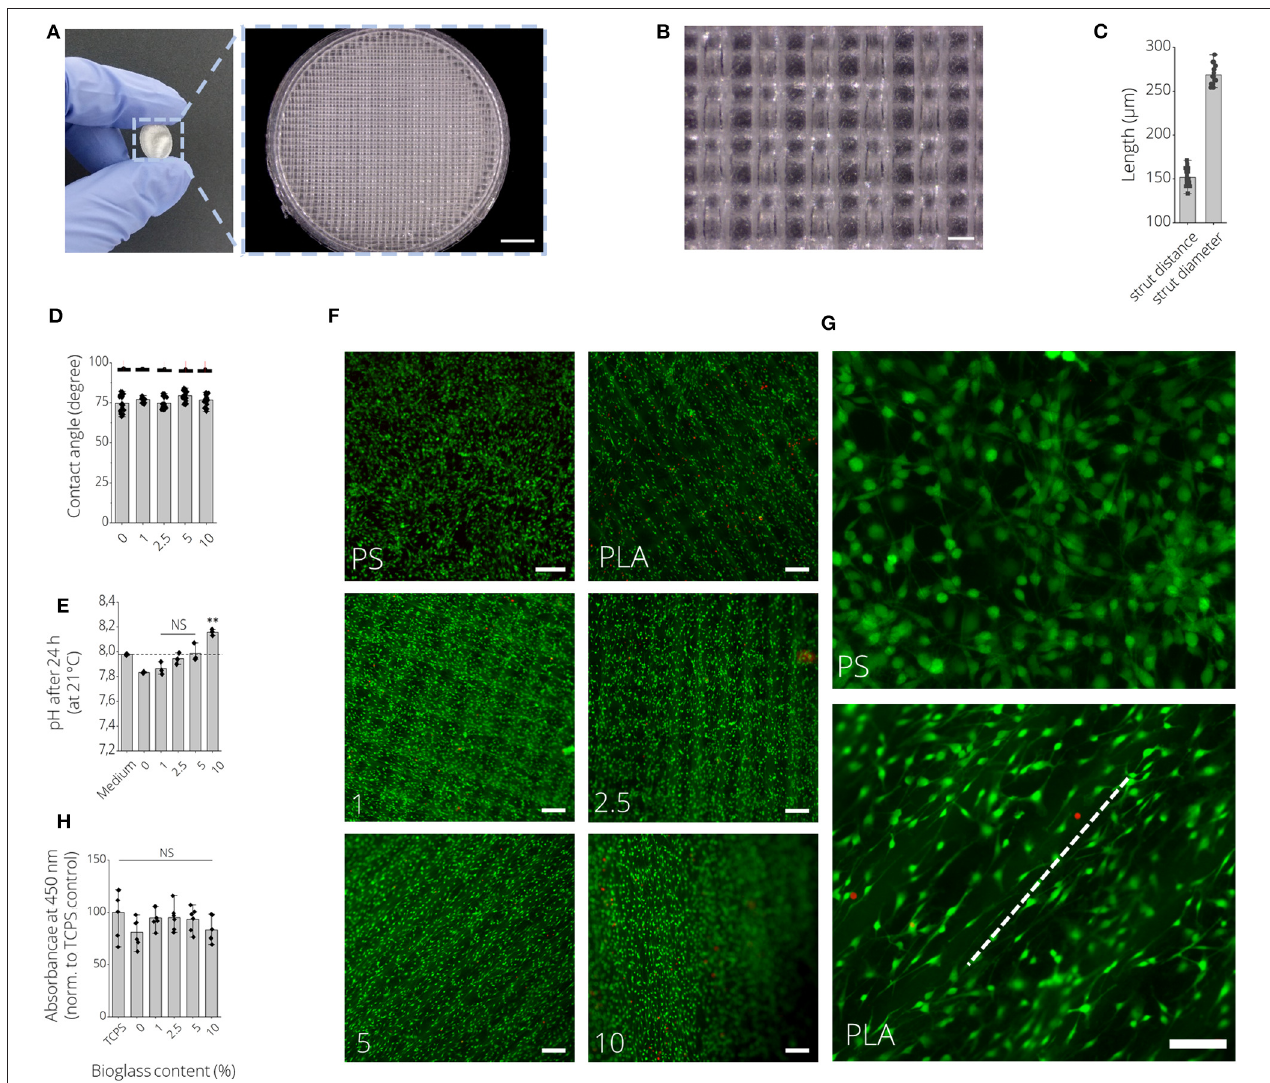
FIGURE 6 | 2D in vitro cytocompatibility assessment of FDM 3D printed PLA-BG disks. (A) Macroscopic image of a 3D printed PLA-BG disk used for initial cytocompatibility assessment. Light microscopy image illustrates the patterned surface of the FDM 3D printed PLA-BG disk. Scale bar: 2mm. (B) Representative light microscopy image of the grit-like strut-by-strut surface structure of the cell-culture disk. Scale bar: 200 µ m. (C) Corresponding quantification of distance between two struts and strut diameter. (D) Water contact angle as a measure of wettability of PLA-BG disks ( n = 6). Data presented as mean ± SD. (E) Development of pH value of cell culture medium incubated with 3D printed PLA-BG disk of 0, 1, 2.5, 5, and 10% (wt) BG content over 24h at 37 ◦ C, measured at 21 ◦ C. No significant increase in pH (NS) except for 10% (wt) BG-laden PLA disks was observed ( n = 6). Data presented as mean ± SD. ** p < 0.01 compared to untreated cell culture medium by one-way ANOVA. (F) Fluorescence microscopy images of Calcein AM (green) and propidium iodide (red) stained MC3T3E1 cells after 24h of incubation on PLA-BG disk and polystyrene reference substrates depicting LIVE/DEAD cells, respectively. Scale bars: 200 µ m. (G) Cell orientation was present on PLA-BG disks (dashed white line) in comparison to PS cell culture well plates. Scale bar: 200 µ m (both images). (H) Corresponding indirect viability WST-8 assay data with no significant (NS) difference in viability detected among the